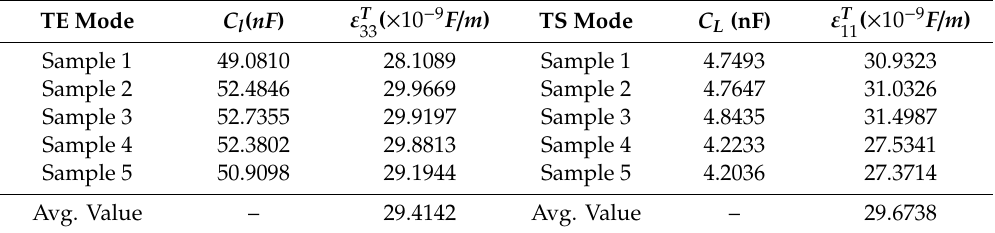
Table 4. Capacitance and dielectric constant measured at 1 kHz in TE and TS mode.